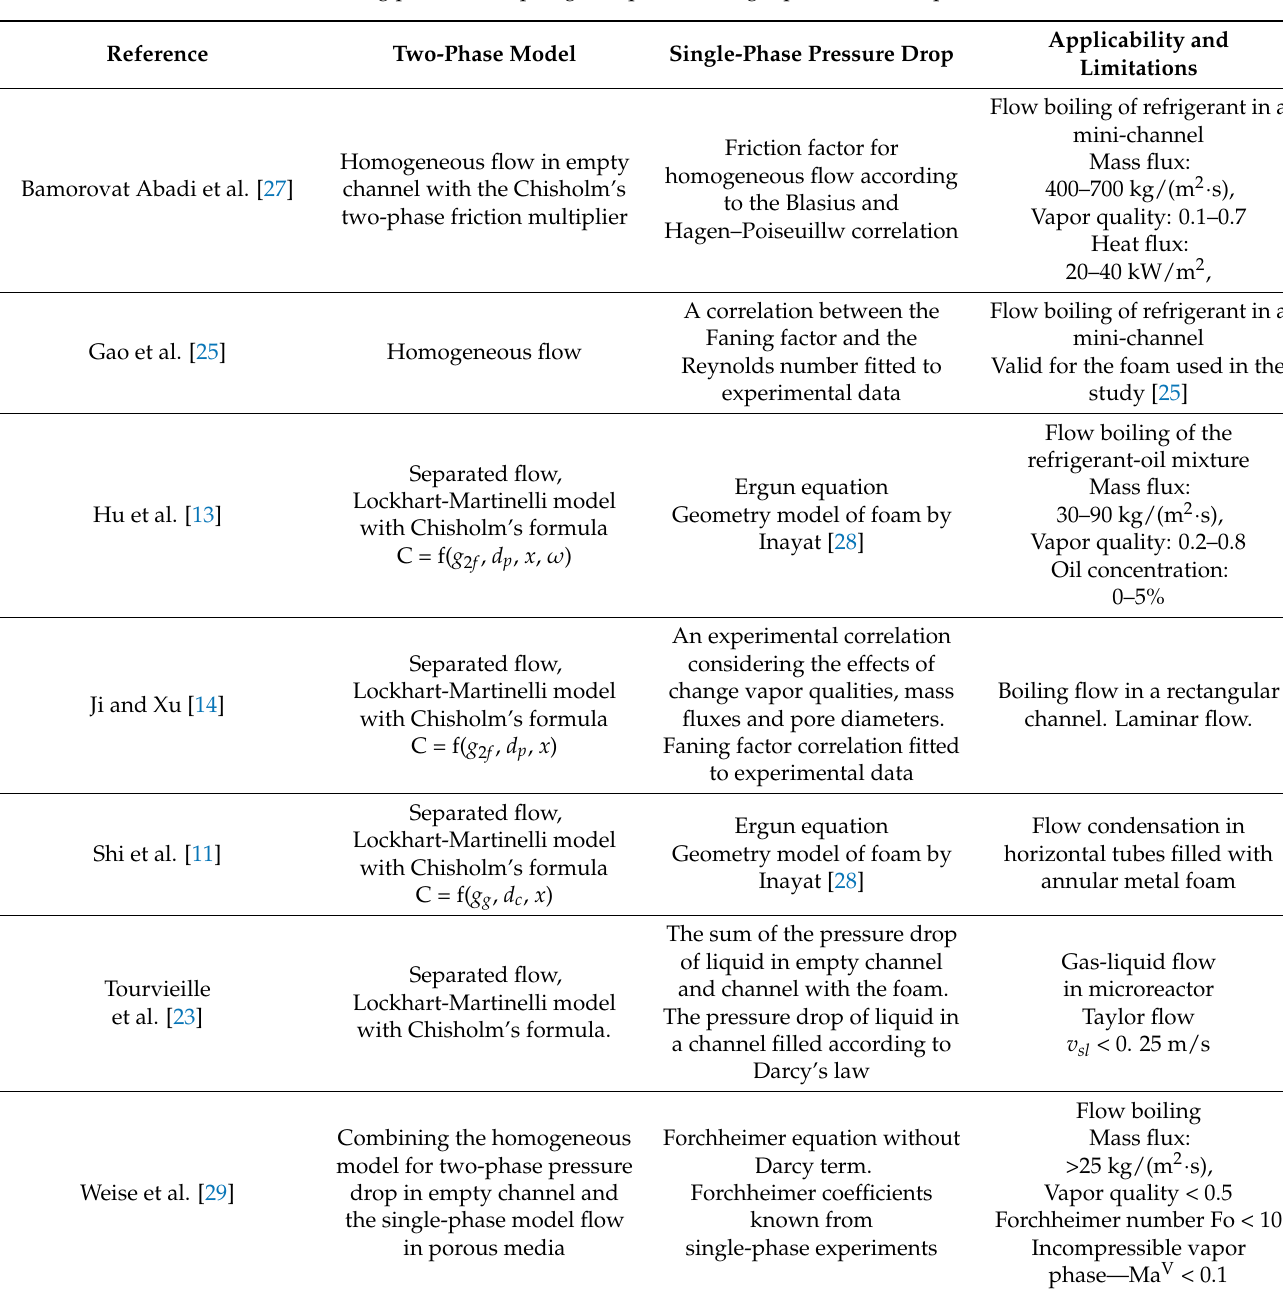
Table 2. Mathematical description of the pressure drop in two-phase gas–liquid flow through metal foams presented in the literature. (Correlations describing pressure drop in gas–liquid and single-phase flow are presented in Table